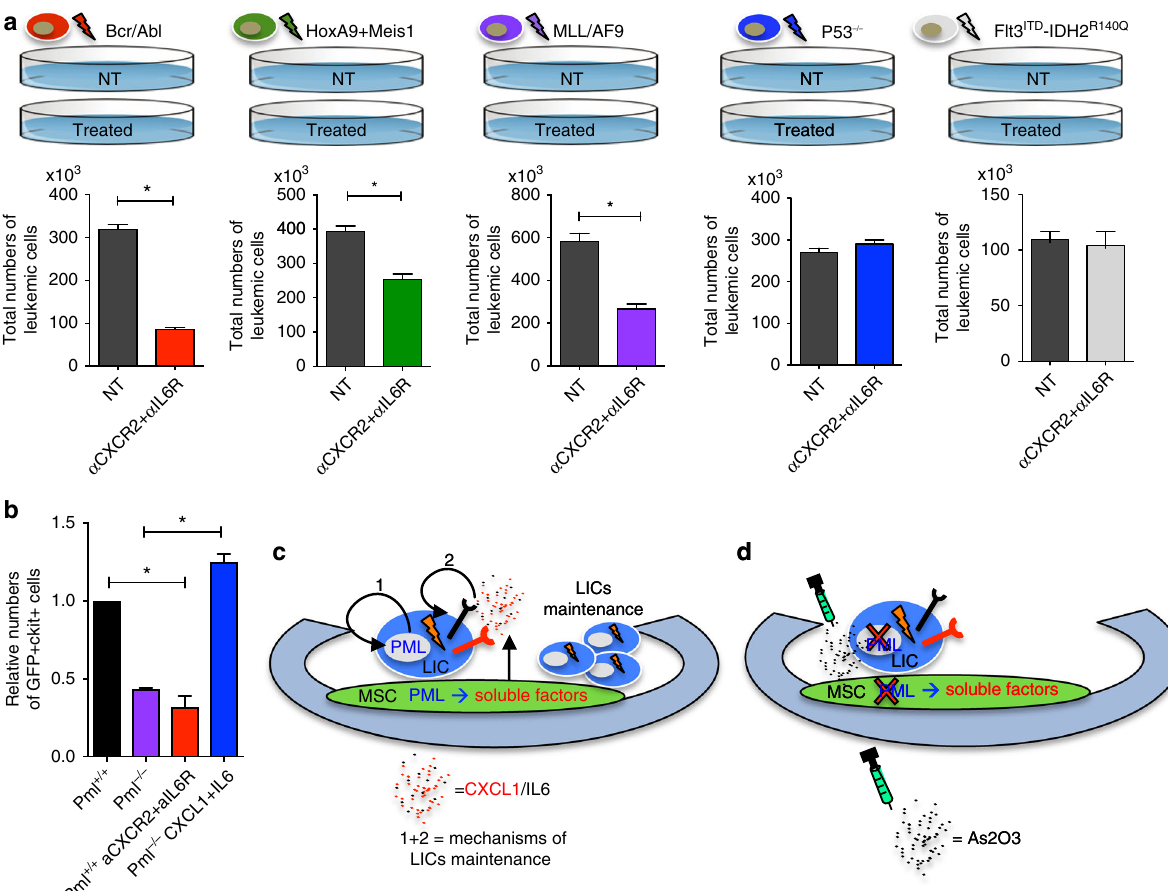
Fig. 6 Pml regulates LICs non-cell autonomously through Il6 and Cxcl1 pathways. a The schematic overview of the experimental design is depicted in the upper panel. The numbers of leukemic cells with different genotype, derived from co-cultures treated with the combination of anti-IL6R and anti-CXCR2, are shown in the lower panel. Data are shown as average ± SEM. ( n ≥ 2 independent experiments). b Co-cultures of MSCs Pml +/+ and HoxA9 – Meis1 + GFP + leukemic cells were untreated (NT) as control, or treated with anti-CXCR2 in combination of anti-IL6R. Co-cultures with MSCs Pml − / − and HoxA9 – Meis1 + GFP + leukemic cells were untreated as control, or treated with recombinant Il6 and Cxcl1 proteins. Leukemic cells were then re-plated onto new MSCs ( Pml +/+ or Pml − / − ); secondary co-cultures were analyzed for the presence of GFP + ckit + cells. The relative numbers of GFP + ckit + cells in the different conditions are shown. Data are shown as average ± SEM. c Schematic representation of the proposed model. In MSCs, Pml regulates the secretion of pro- in fl ammatory soluble factors, which sustain the maintenance of leukemic cells and those enriched for LIC capacity. Pml sustains leukemic cells in a non- cell-autonomous manner, in cooperation with the cell-autonomous mechanisms within LICs, as previously described. d Pml degradation, (achieved for example through treatment with arsenic trioxide (AS 2 O 3 )), contributes to eliminate leukemic